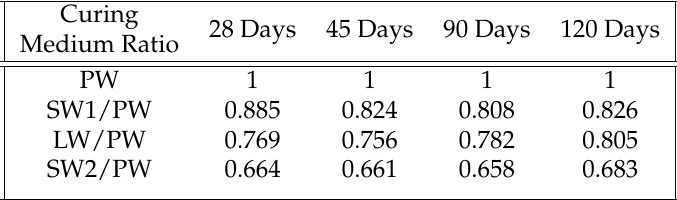
Table 9. Validation of developed models for the compressive strength of concrete cured in different curing medium Curing Age (Days)